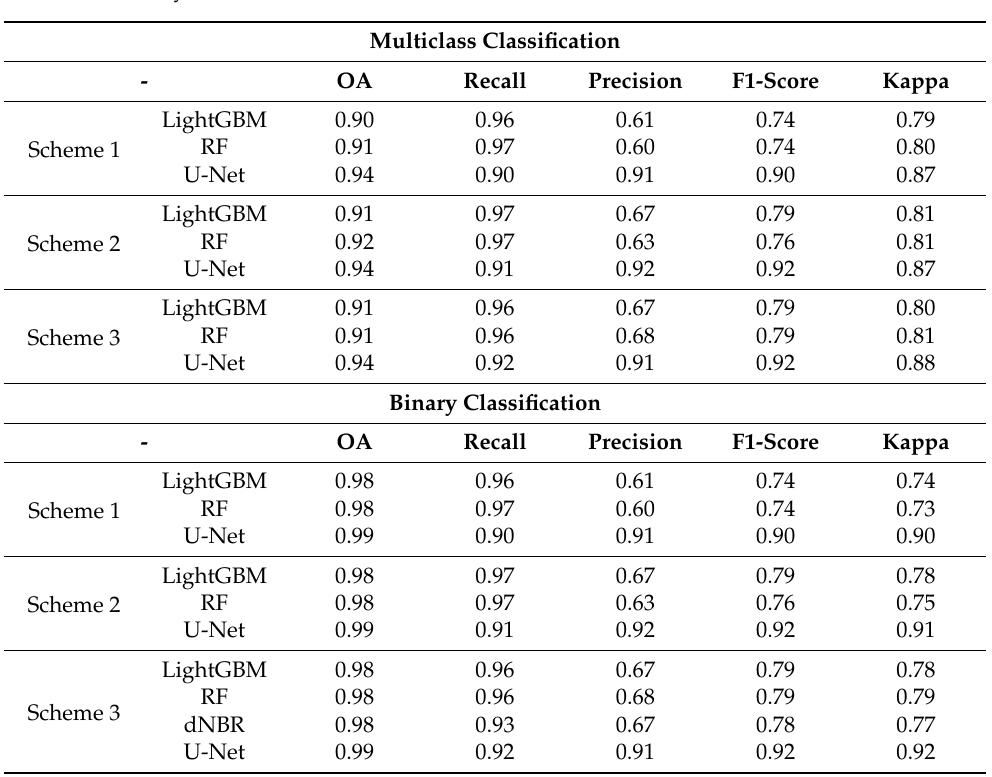
Table 5. Summary of the burned area detection results for Site